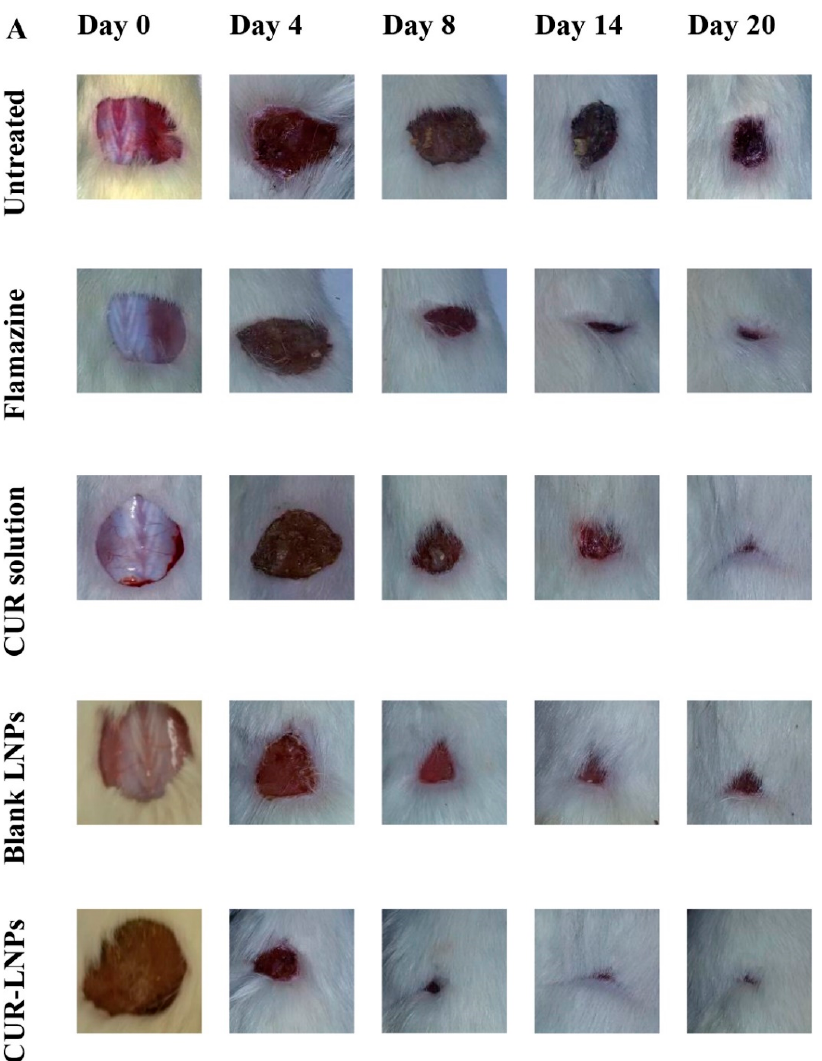
Figure 7. Wound healing efficacy of CUR-loaded LNPs compared to untreated (control), Flamazine, CUR solution, and blank LNPs. Adopted with permission from [132], Elsevier, 2020.